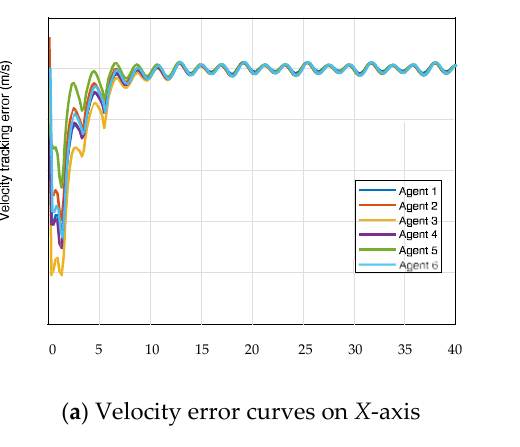
Figure 3. Velocity error curves of six agents.